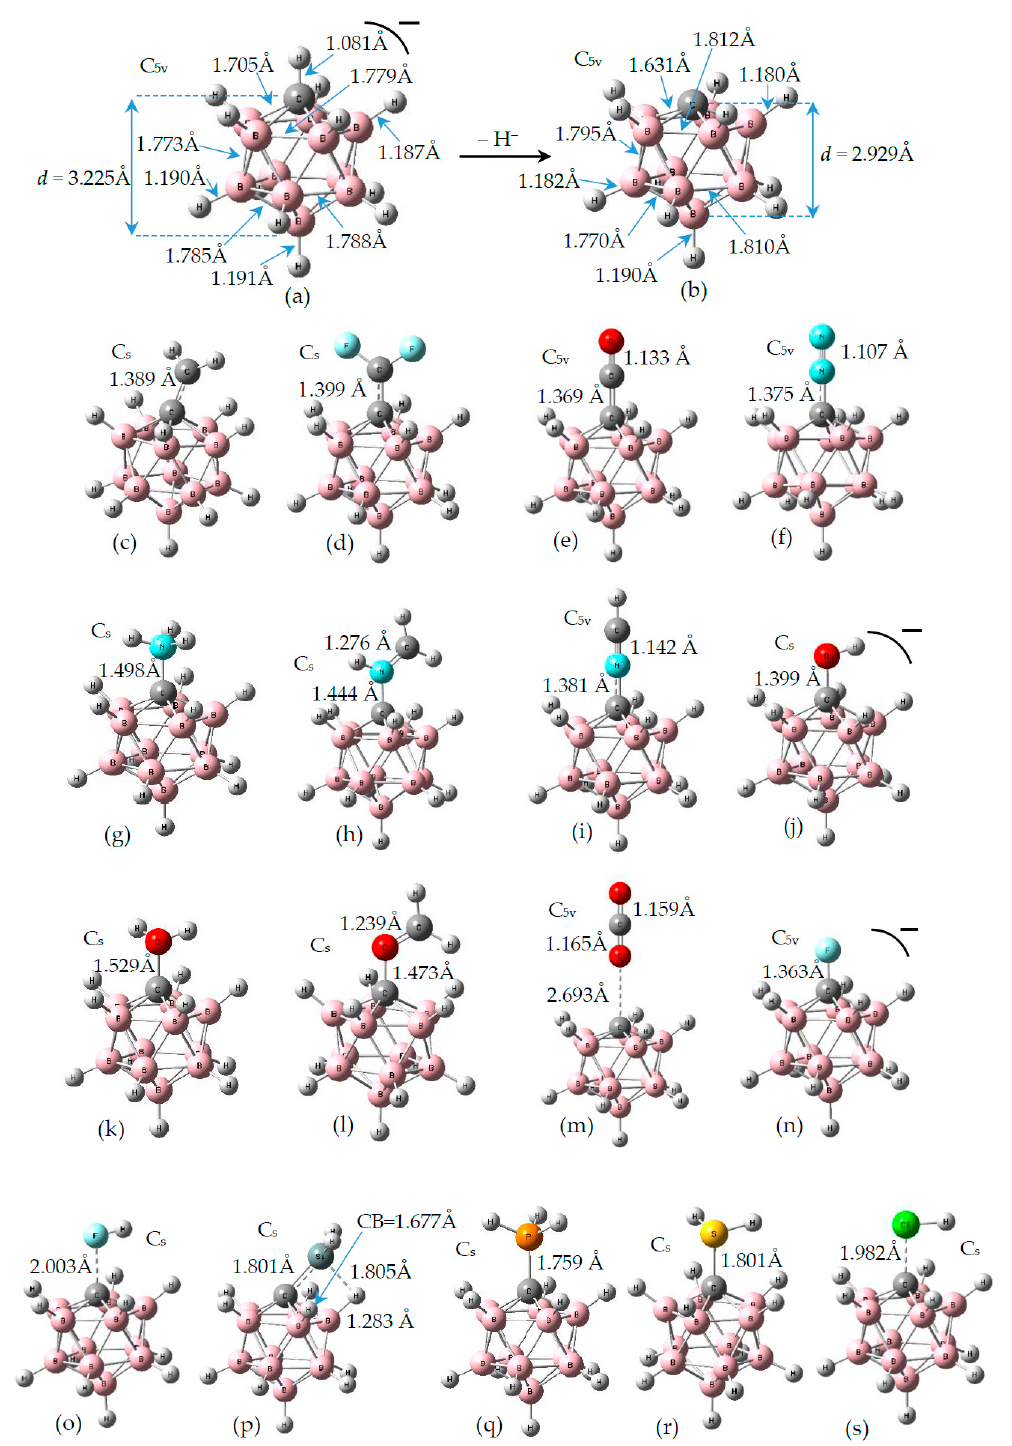
Figure 2. Structures of the G4MP2 optimized geometries for the 18 tetrel complexes ( 1 : n )—with n = 2 – 19 —considered in this work, following Scheme 1: ( a ) The known anion CB 11 H 12( − ) corresponding to complex ( 1 : 2 ), ( b ) carbenoid CB 11 H 11 ( 1 ),